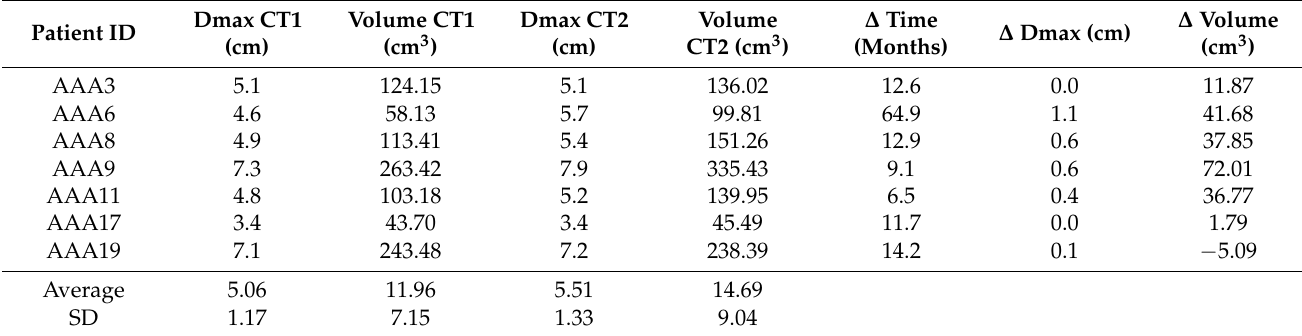
Table 2. Clinical measurements of diameters and volume over